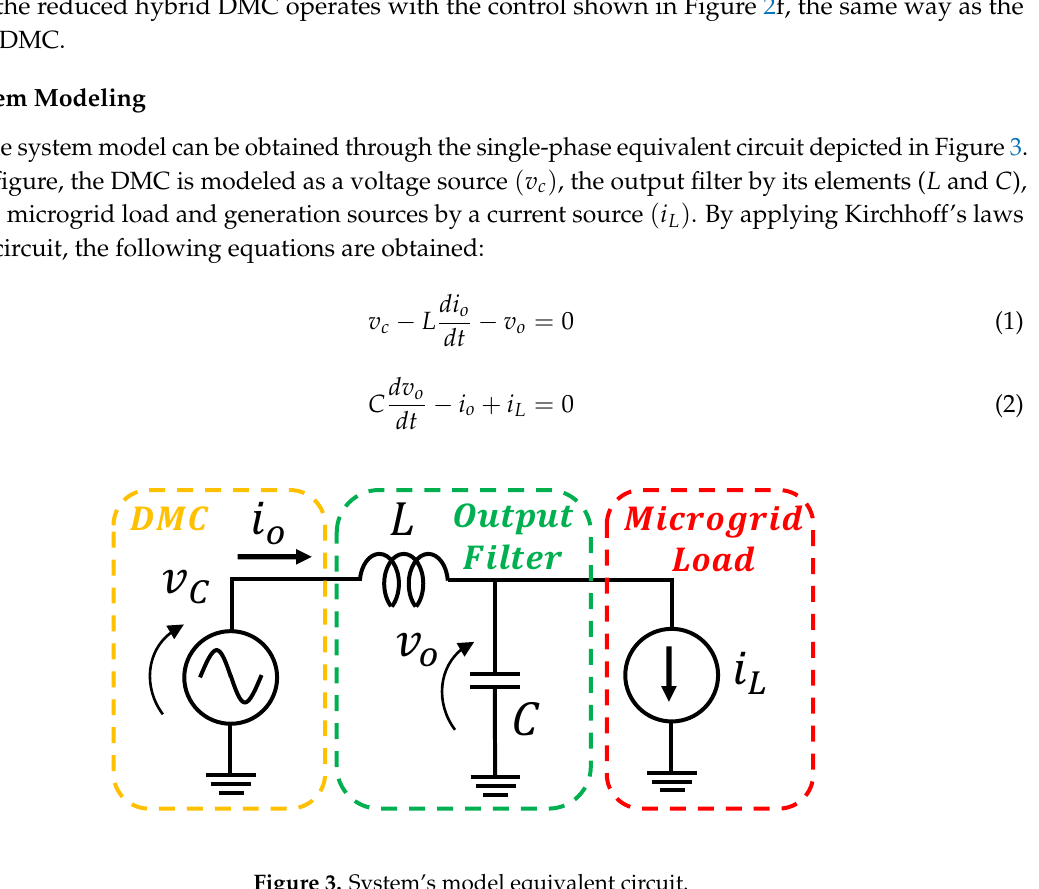
Figure 3. System’s model equivalent